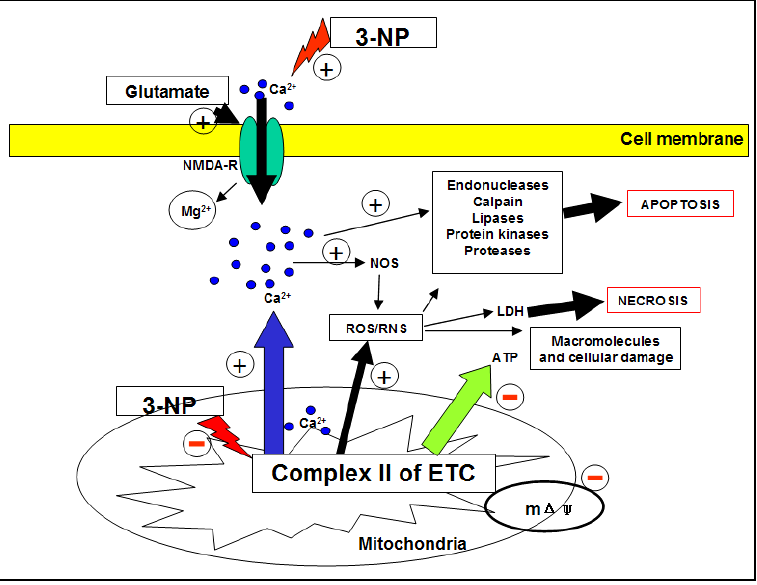
Figure 2. Neurotoxicity by 3-NP: 3-NP promptes complex II inhibition and increased sensibility of NMDA-R (excitotoxicity). 3-NP toxicity affects microglia, astrocytes and neurons, and causes secondary excitotoxicity by making neurons more vulnerable to endogenous basal levels of glutamate, while prompting a reduction of ATP availability. This scenario causes relief of voltage-dependent Mg 2+ blockade at the NMDA-R pore. In turn, the activation of these receptors leads to massive entry of Ca 2+ to cytoplasm and further activation of a number of calcium dependent enzymes, including calpains and